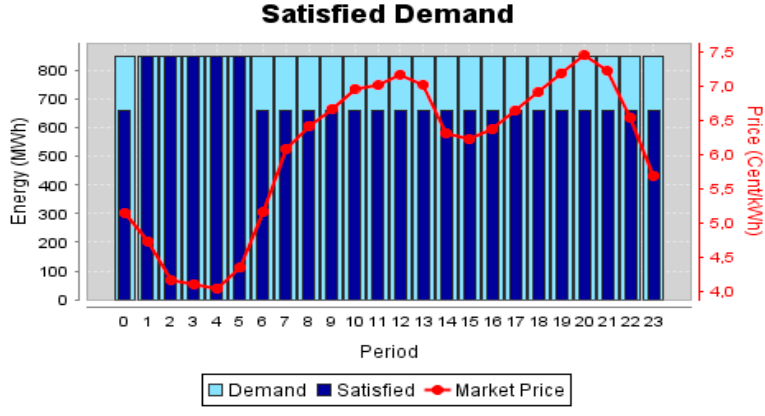
Figure 13. Satisfied market demand.